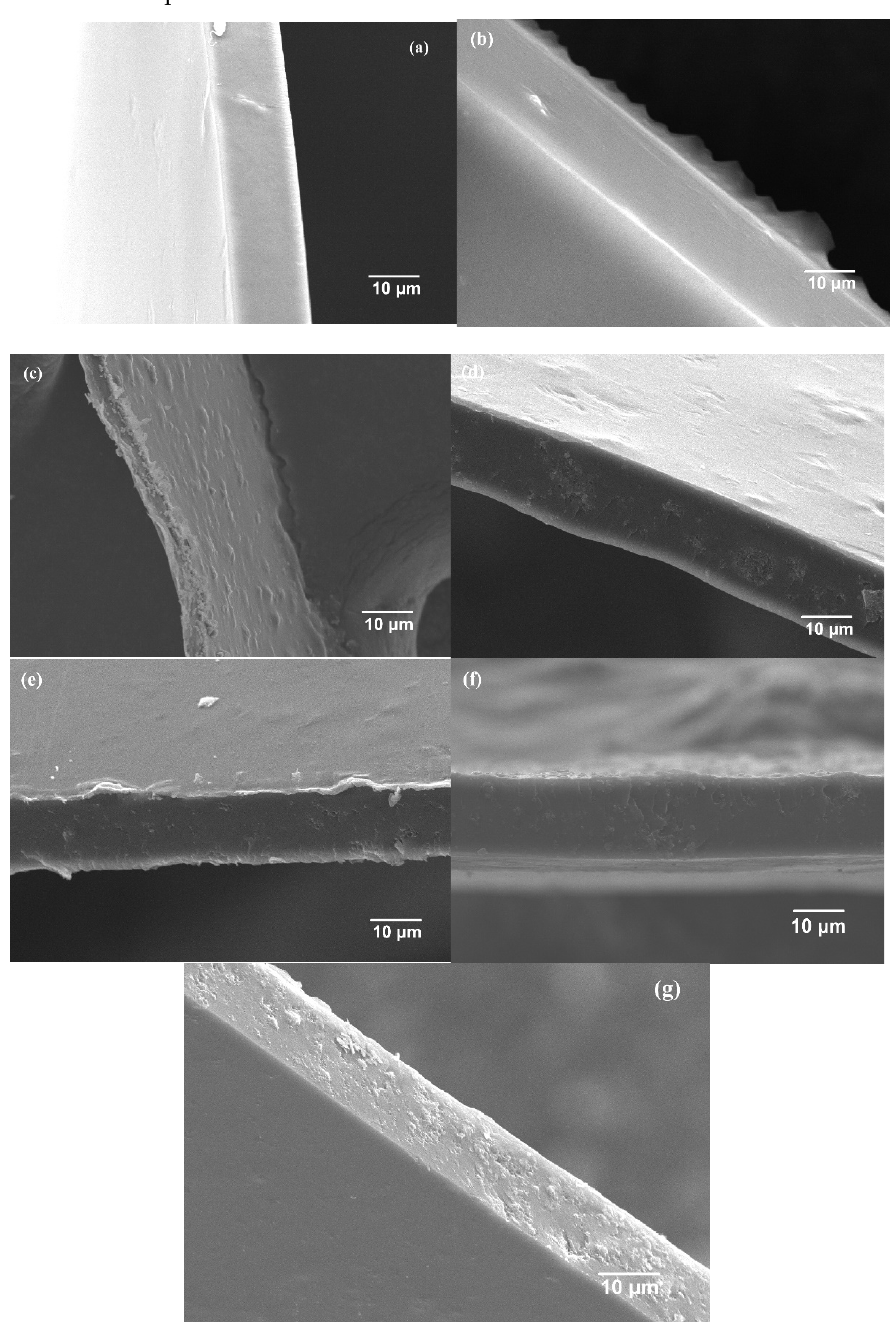
Figure 7. SEM of cross section surface of CEMs. ( a ) Blank sPPO membrane; ( b ) 0.2 wt.% HZCs-sPPO; ( c ) 0.5 wt.% HZCs-sPPO; ( d ) 0.7 wt.% HZCs-sPPO; ( e ) 1.0 wt.% HZCs-sPPO; ( f ) 1.3 wt.% HZCs-sPPO; ( g ) 1.5 wt.% HZCs-sPPO.